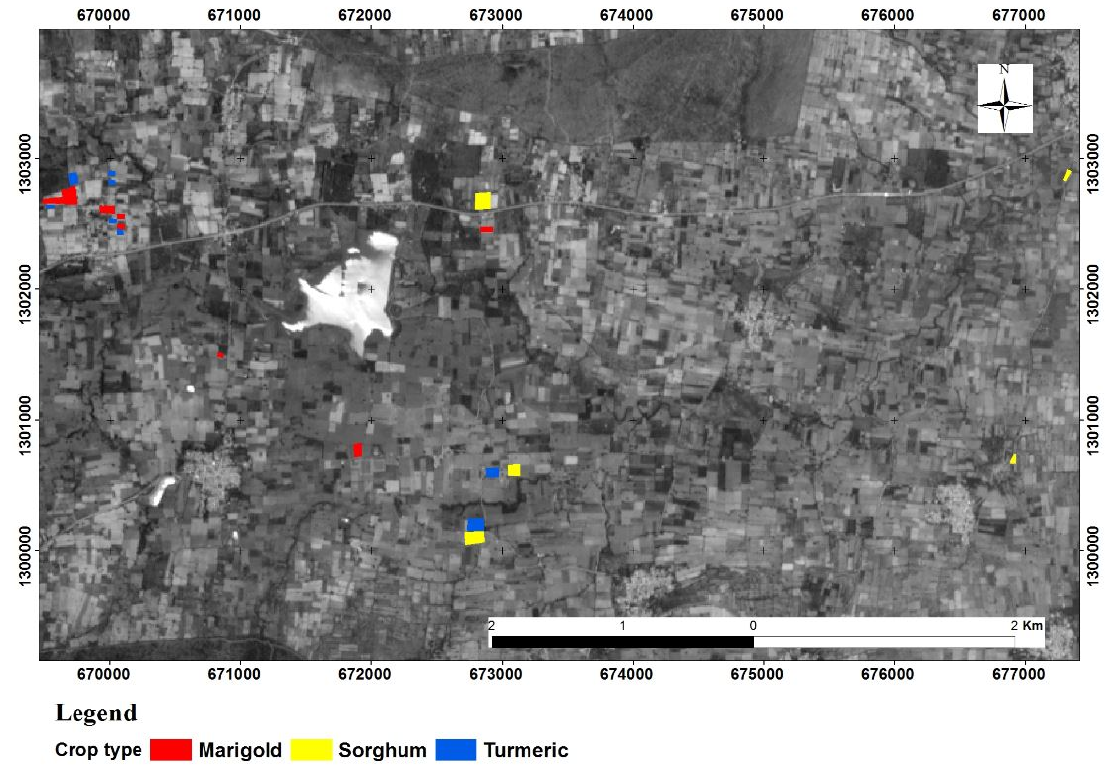
Figure 1. View of the Berambadi watershed, showing the location of studied plots of marigold, sorghum, and turmeric.